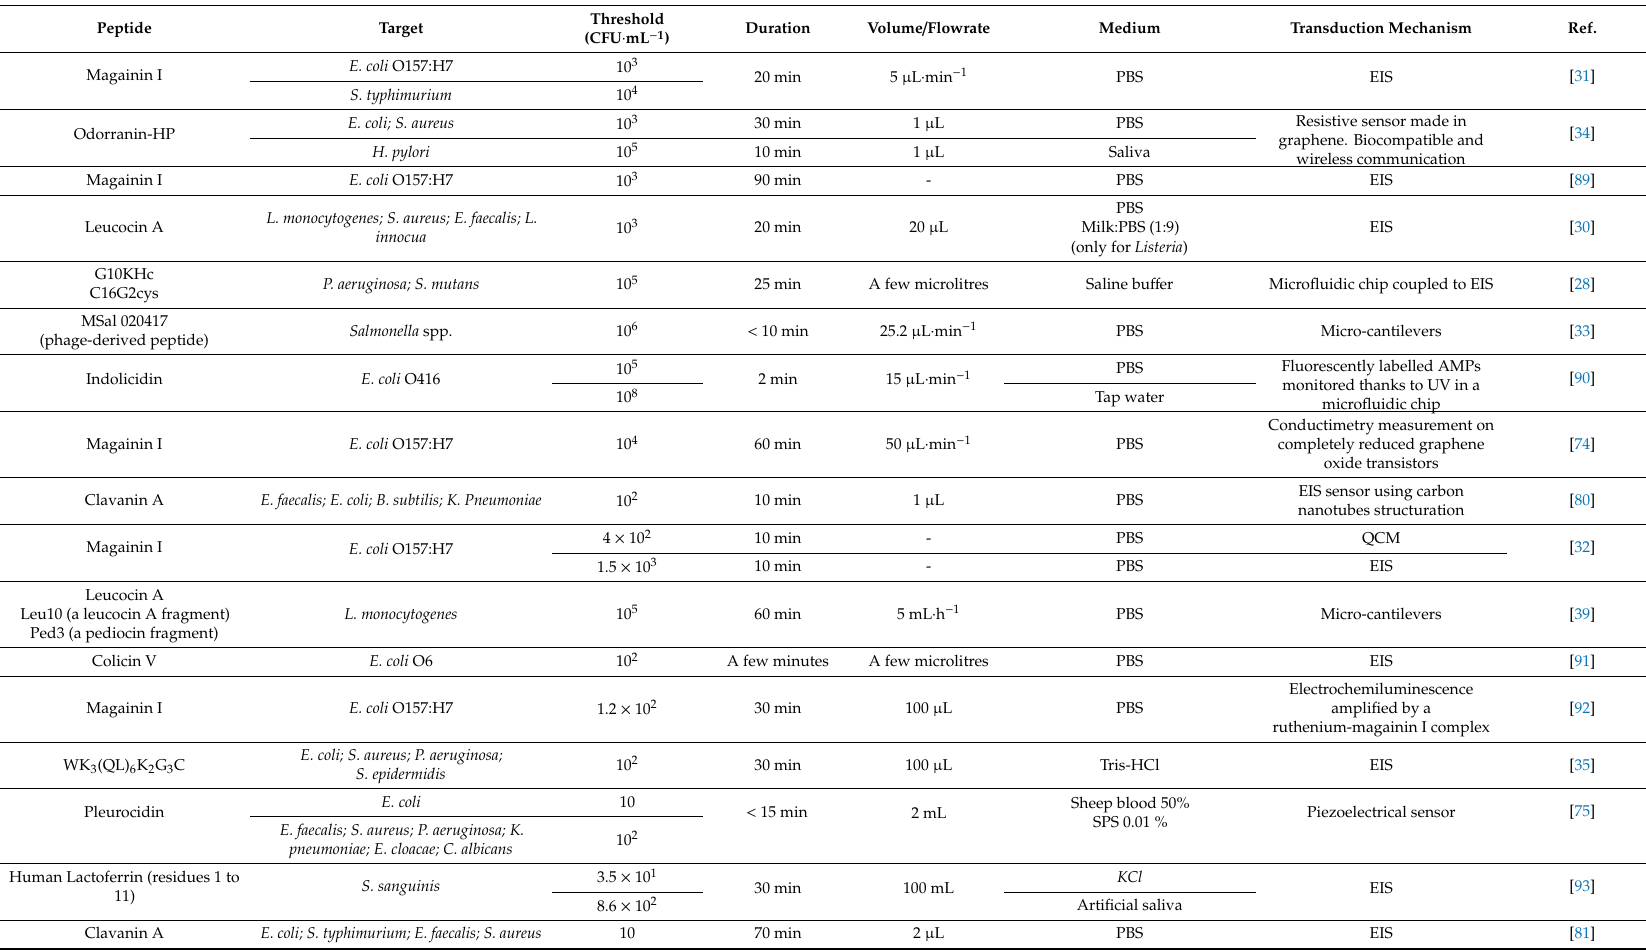
Table 2. Biosensors based only on AMPs for recognizing bacterial targets. Articles are classified